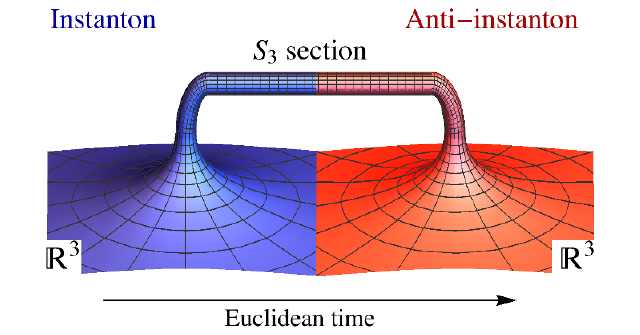
Figure 1 . Pictorial representation of an euclidean wormhole with endpoints connected to the same asymptotically (cid:13)at space. The Euclidean time runs in the direction of the arrow. At each instant of time, two space dimensions have been suppressed. The cross-section of the wormhole throat is a three-sphere S 3